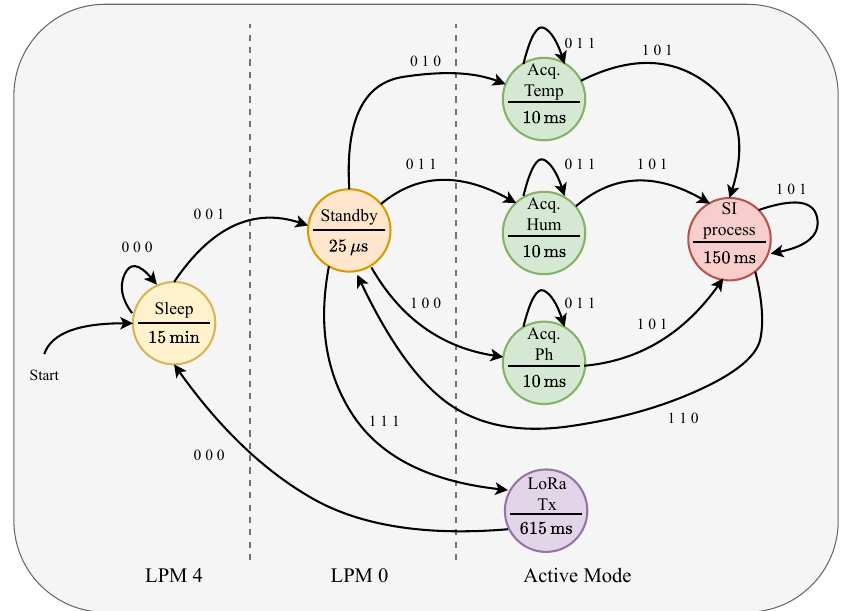
Figure 7. State transition graph of the power management